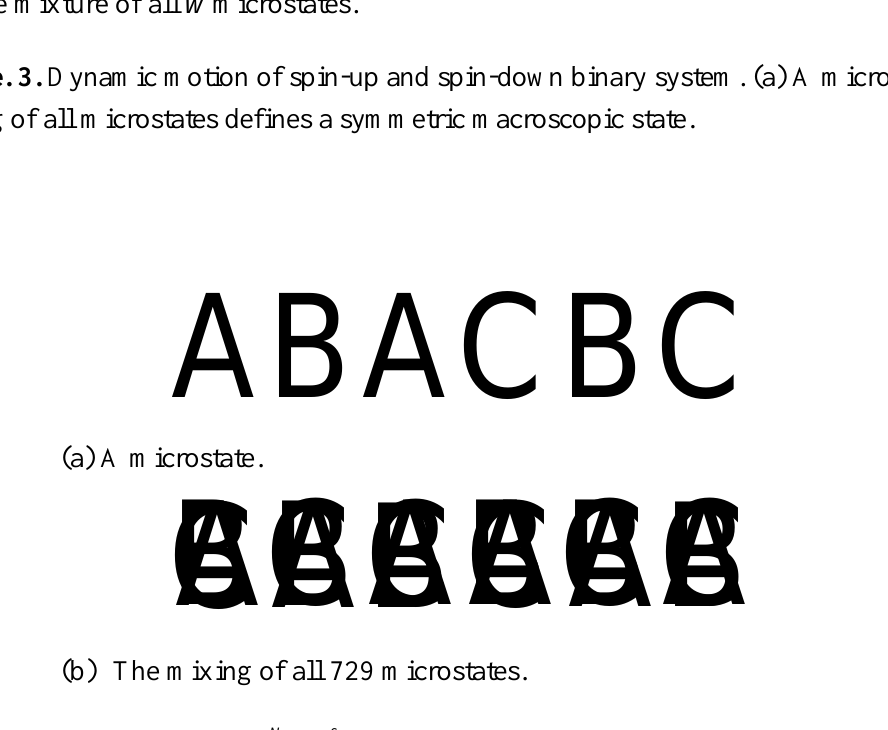
Figure 4. (a) One of 729 ( 6 3 3 729 N = = ) microstates. (b) Schematic representation of information loss due to dynamic motion. The pictures at the six positions are the same, hence they give a symmetric macroscopic state. All the three letters appear at a position with the same probability. All the microstates also appear with the same